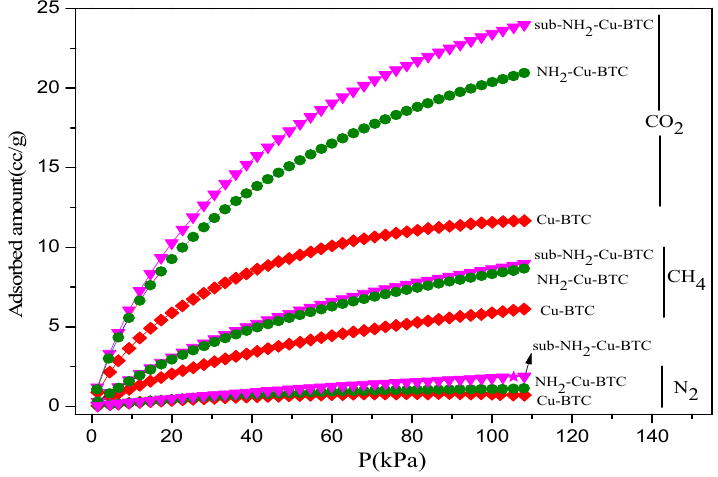
Table 1. Physical and textural properties of Cu-BTC.